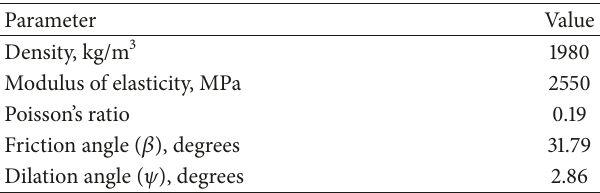
Table 1: Mechanical properties of masonry